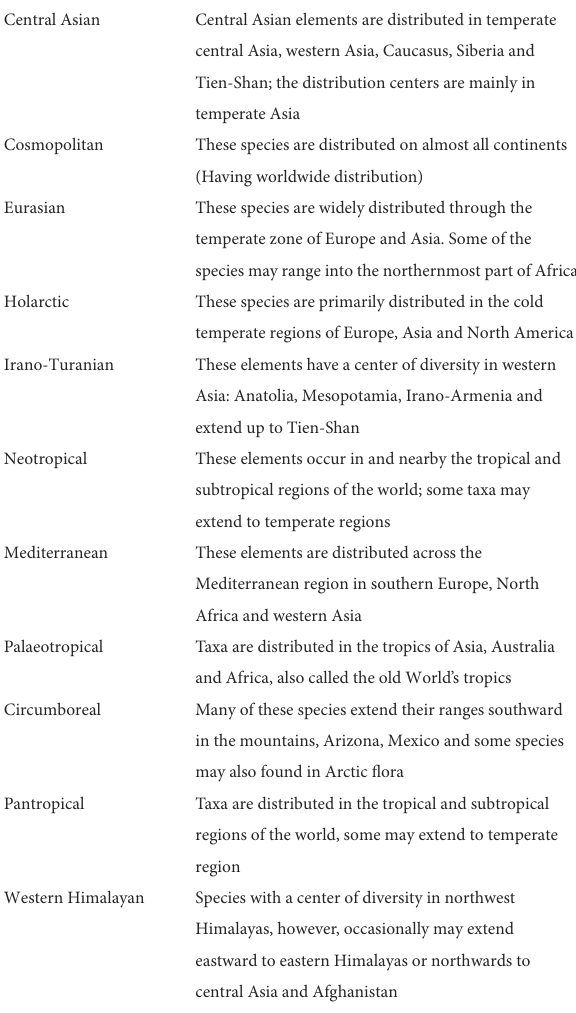
TABLE 1 A description of the floristic elements in Bin Dara, Pakistan. Floristic elements Description